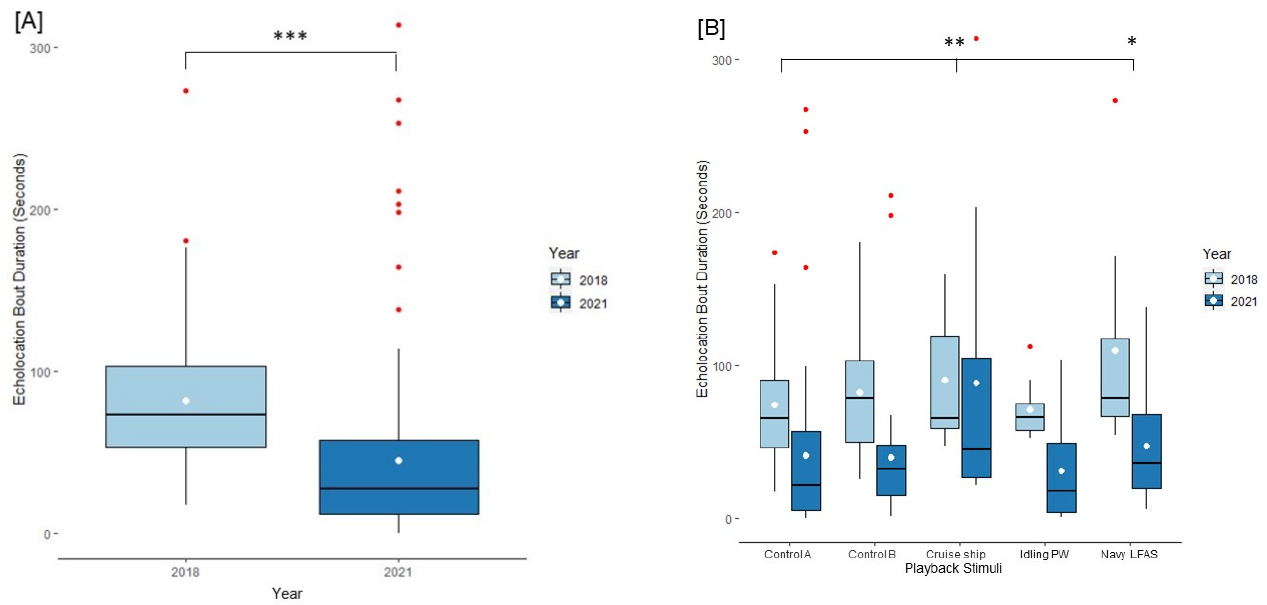
Figure 7. Echolocation Bout Duration Responses separated by fixed effect factors. ( A ) Box and whisker plot representing the IQR and medians of echolocation duration responses in 2018 and 2021 visits. Means are represented by white dots. ( B ) Box and whisker plot representing data range of echolocation durations by playback type with outliers denoted in red. * = p < 0.05, ** = p < 0.01, *** = p < 0.001. Idling PW = idling personal watercraft.